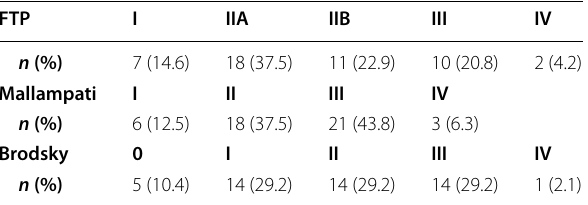
Table 2 Physical examination data